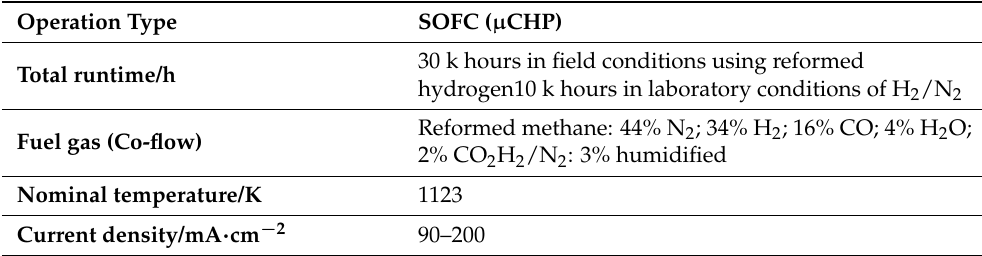
Table 1. Operating parameters for the